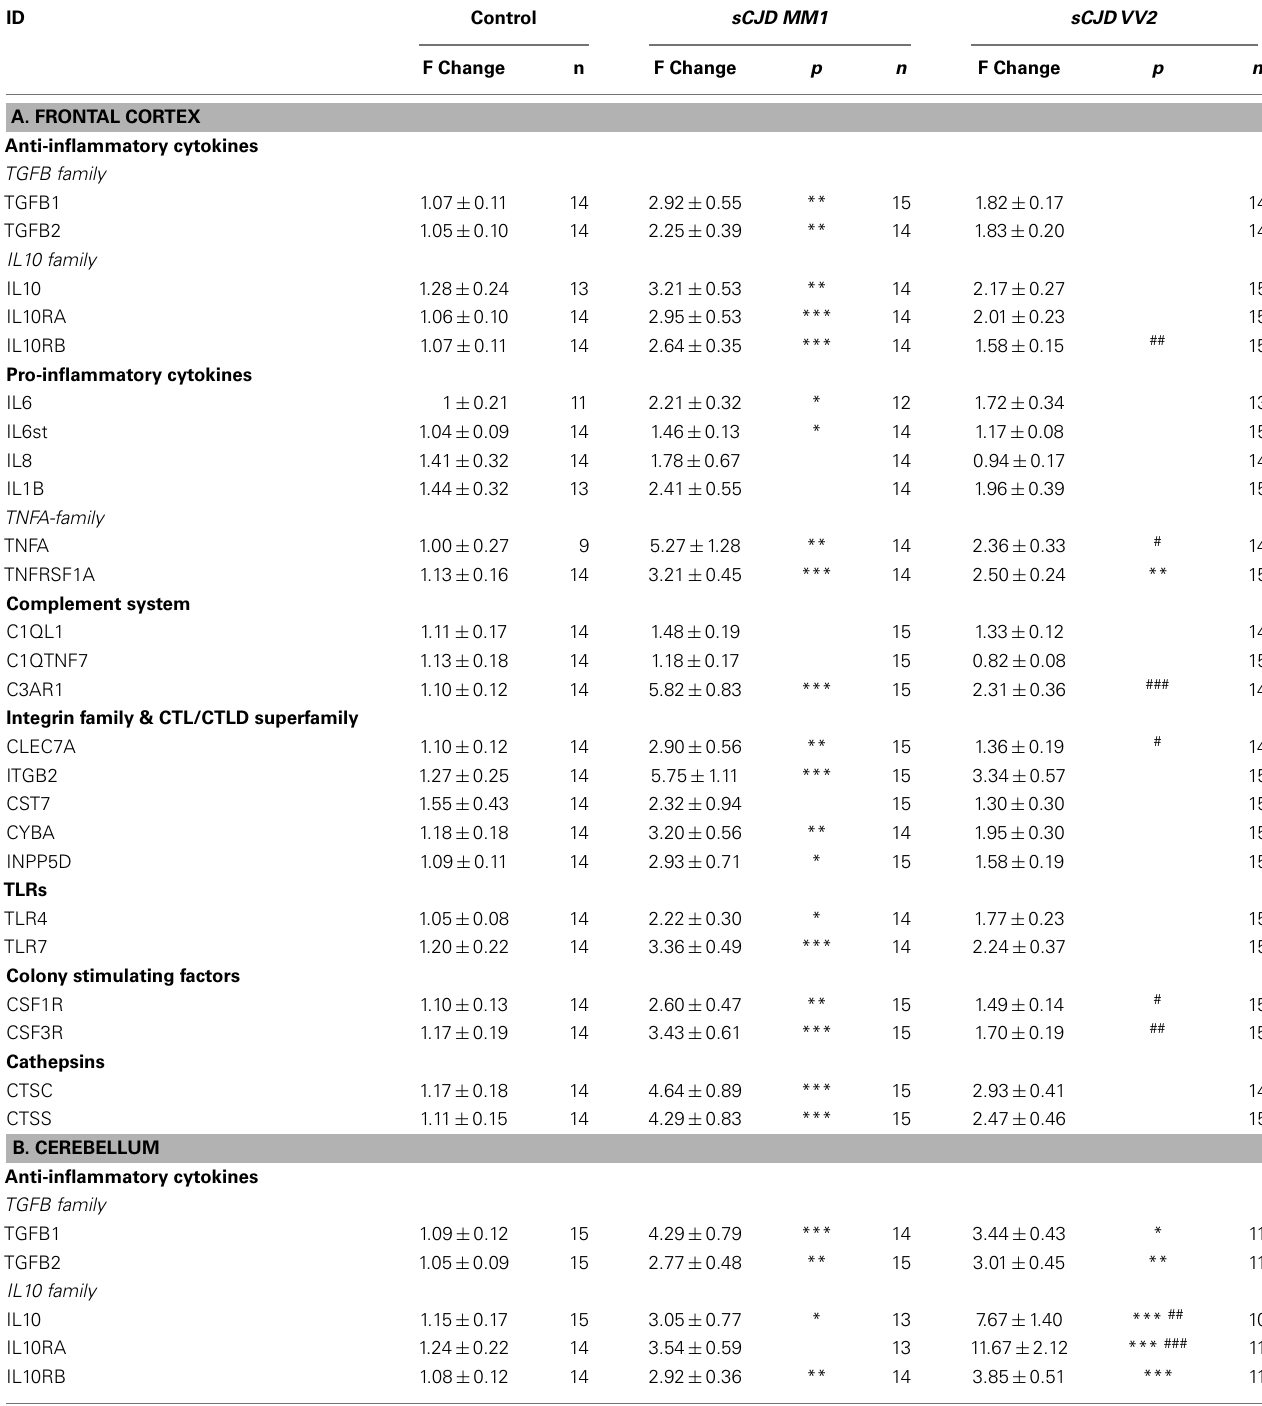
Table 1 | (A) mRNA expression of inflammatory mediators in the frontal cortex (area 8) of control and sCJD subtypes MM1 andVV2. (B) mRNA expression of inflammatory mediators in the cerebellum of control and sCJD subtypes MM1 andVV2